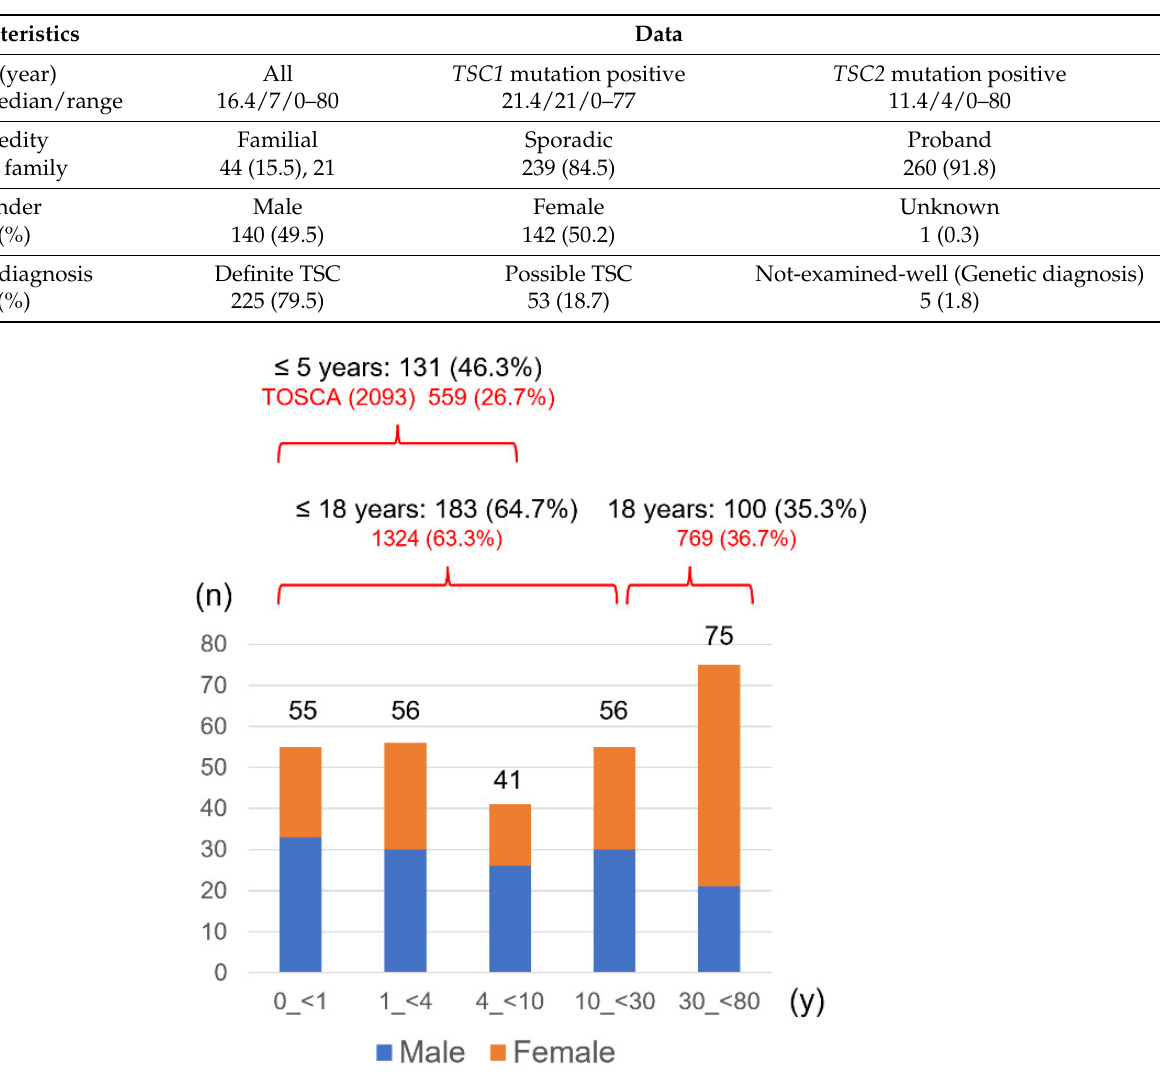
Table 1. Demographics of the participants ( n = 283).